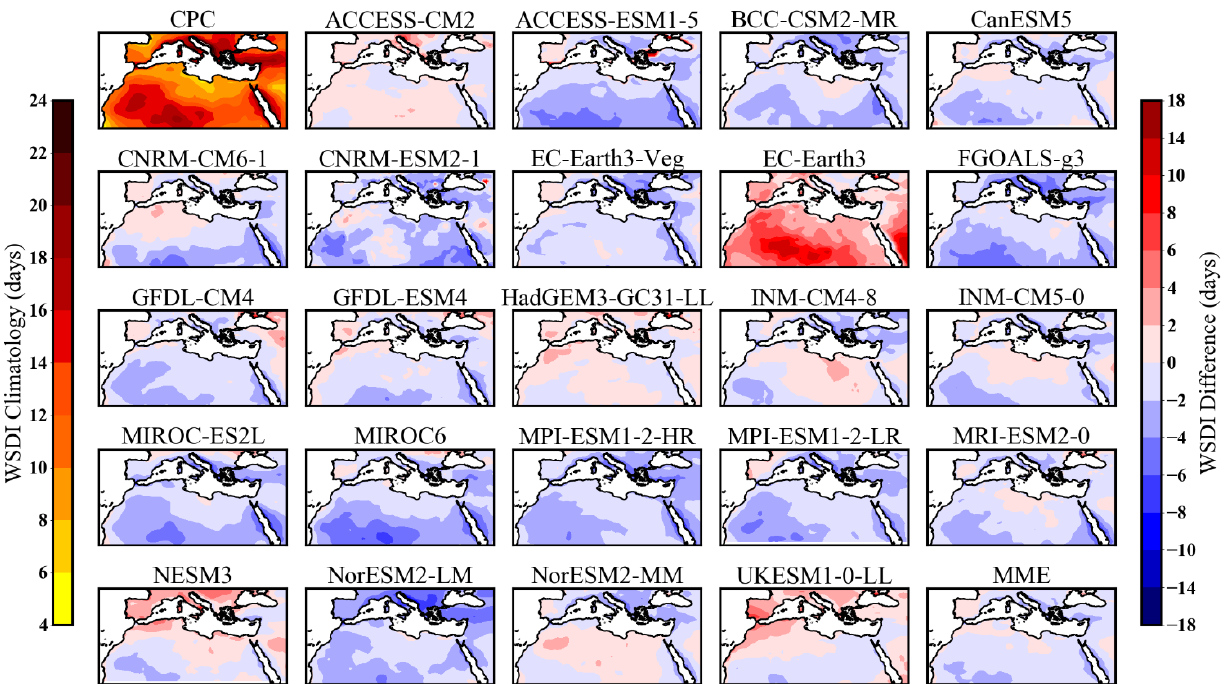
Figure 5. Spatial distribution of warm spell duration index (WSDI) difference from the CMIP6 GCMs and their MME during 1979–2014. The first plot shows the climatology of WSDI from CPC. The model difference is calculated as model (after correction) minus CPC.